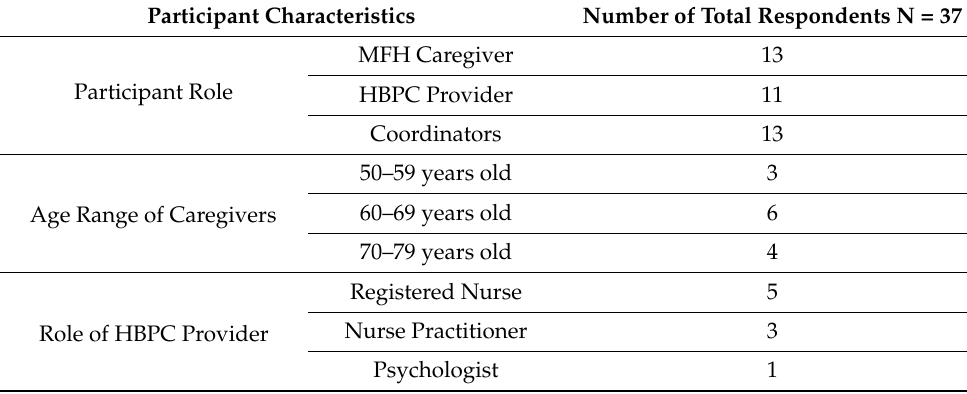
Table 1. The Characteristics of the Study Sample.